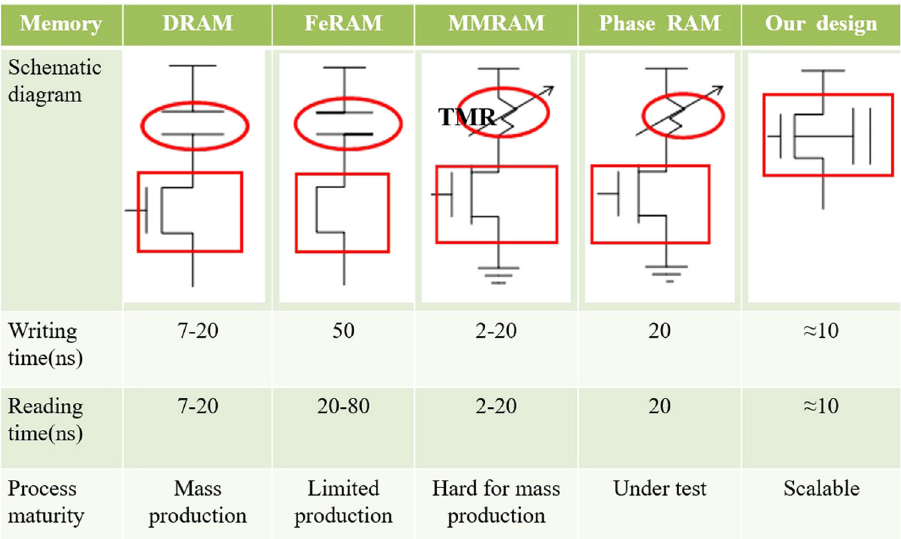
Fig. 3 Comparison between different memory designs. DRAM needs one capacitor and one transistor, FeRAM, MRAM, and PRAM need dedicated materials such as ferroelectrics to introduce the capacitor effect, which deviates from the silicon foundry processing and challenges the mass production. Our design involves only one transistor with no additional materials and compatibility with the Si foundry lines.